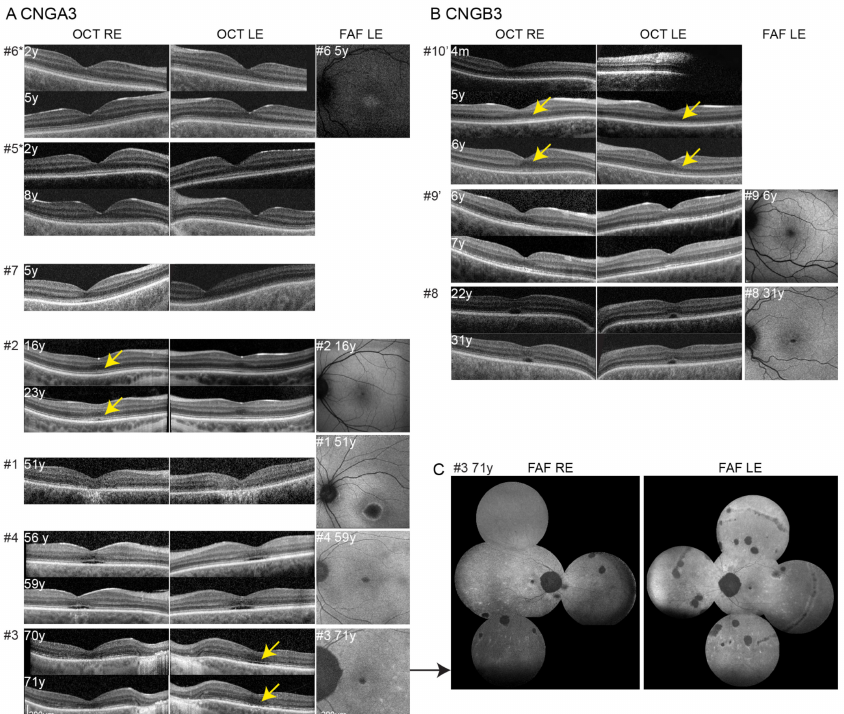
Figure 2. Optical coherence tomography and fundus autofluorescence. OCT images at first and follow-up imaging are shown for CNGA3 ( A ) and CNGB3 ( B ) patients. Patients are sorted from the youngest to the oldest from top to bottom. Patients’ number is stated with # on the left of each image. Changes noted on follow-up are marked with yellow arrows. FAF image is shown next to OCT, if available. FAF of the peripheral retina of patient #3 is shown in ( C ). Patients from the same families are marked with * and ‘, respectively.